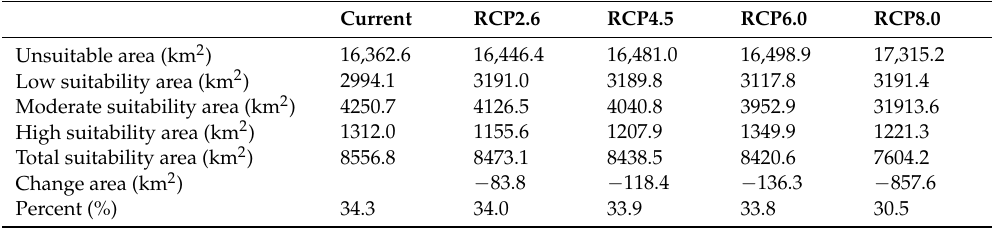
Table 4. Habitat suitability classes area of Qinghai